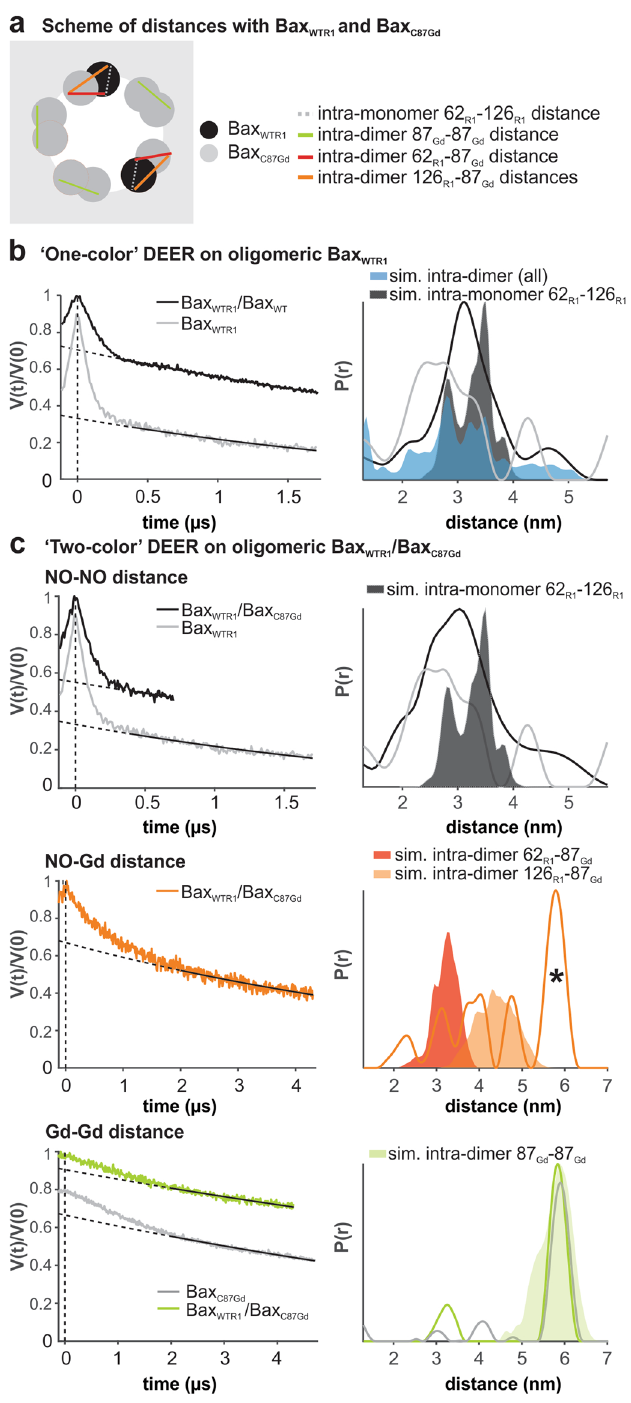
Figure 4. DEER on oligomeric Bax with orthogonal spin labels. ( a ) Scheme of the expected distances . (b,c ) Primary data with background function (left) and distance distributions (right) obtained by Tikhonov regularization with DeerAnalysis2018 54 . The shaded areas present the corresponding distance simulations based on the structures in 18,20 . ( b ) Active Bax WTR1 mixed with 3-fold excess unlabeled Bax WT (black) compared to the undiluted Bax WTR1 (grey). ( c ) Upper panel, NO-NO DEER on active Bax WTR1 with 3-fold excess of Bax C87Gd compared to the Bax WTR1 alone (grey). Central panel, NO-Gd DEER on the same sample. The asterisk highlights a possible channel cross-talk signal. Bottom panel, Gd-Gd DEER on the same sample (green) compared to Bax C87Gd alone (grey). Data evaluation and validation is given in Supp. Fig. 9. The same experiments performed with Bax WTIAG are given in Supp. Figs 10,